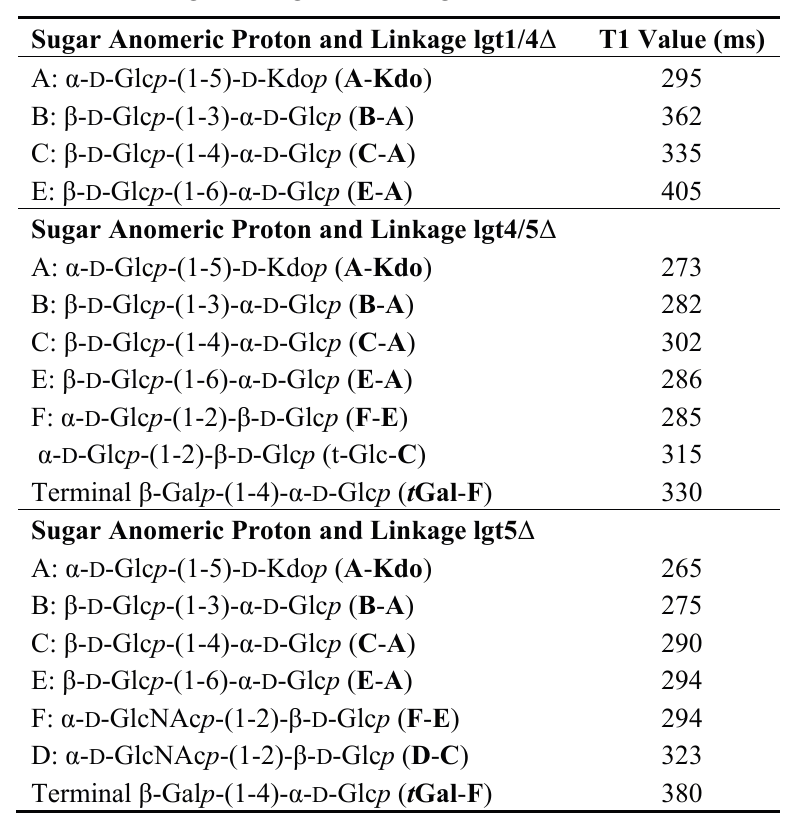
Table 4. 1 H-NMR T1 values (ms, 600 MHz, 298 K) for the anomeric protons of the M. catarrhalis OS mutants lgt1/4 Δ , lgt4/5 Δ and lgt5 Δ